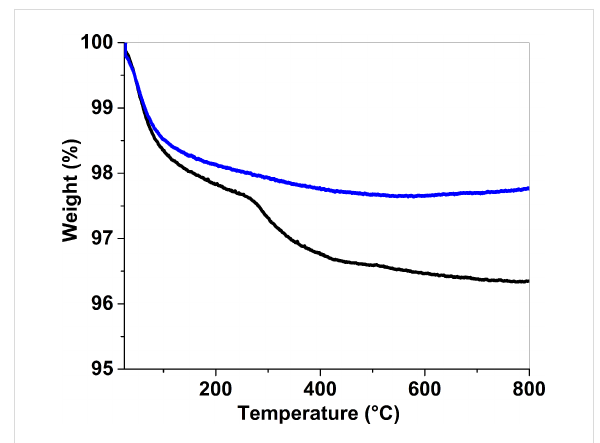
The actual percentage of glutathione (49.4%) is a little less than